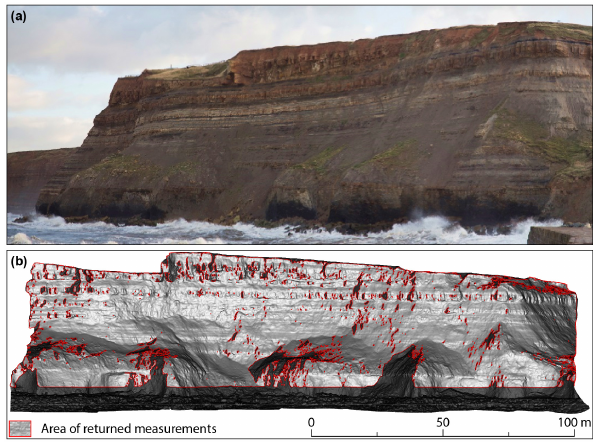
Figure 2. (a) Image of the cliff taken 1h before high tide on 25 November 2015. Horizontally bedded strata are evident, with up- per beds stained orange from downslope wash from glacial till of variable depth. The lower buttress comprises shales and some sand- stone, while the near-vertical upper portion of the cliff comprises outcropping sandstone and sandstone interbedded with carbona- ceous muds. (b) Slope model of the cliff showing the area cov- ered by the TLS (light grey) draped over a 3-D model of the cliff, surveyed from multiple positions along the foreshore (dark grey). The total area measured is 8561m 2 , or 89% of the cliff face area (9592m 2 ). The cliff is ∼ 210m across and ∼ 60m high. Figure 3. Flow diagram representing the stages of the optimised